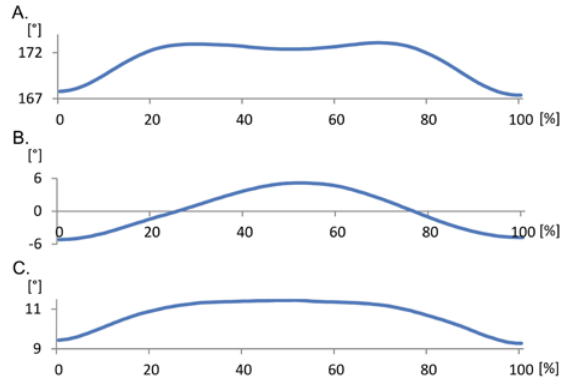
Figure 2. Example of diagrams of mean joint angles of upper limb; A. elbow angle in sagittal plane, B. shoulder angle in sagit- tal plane, C. shoulder angle in frontal plane.